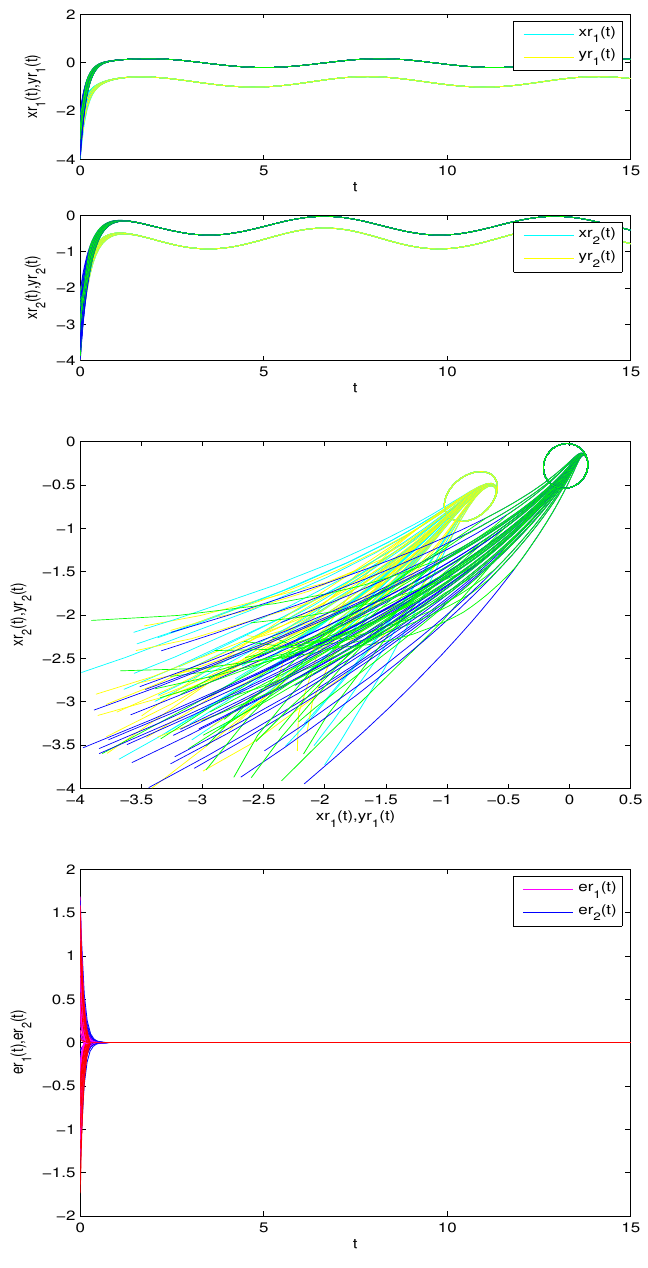
Figure 9. Instantaneous error states for the R part between for the variable ˘ x of (18) and ˘ y of (19) under 30 random initial values for two kinds of